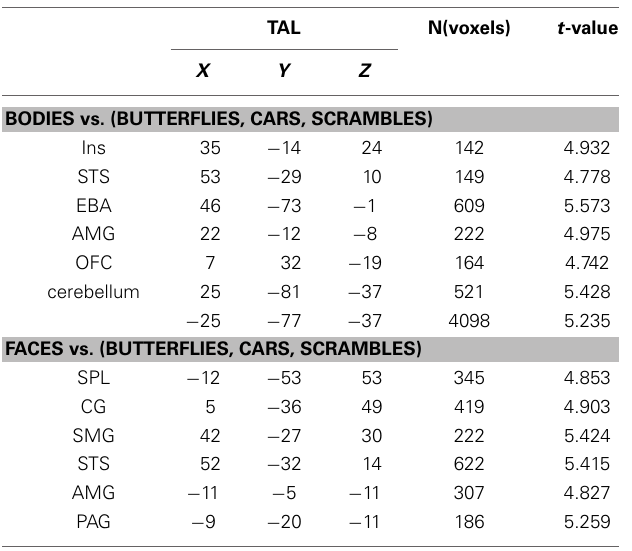
Table 3 | Post-hoc contrasts. X, Y and Z refer to Talairach coordinates.